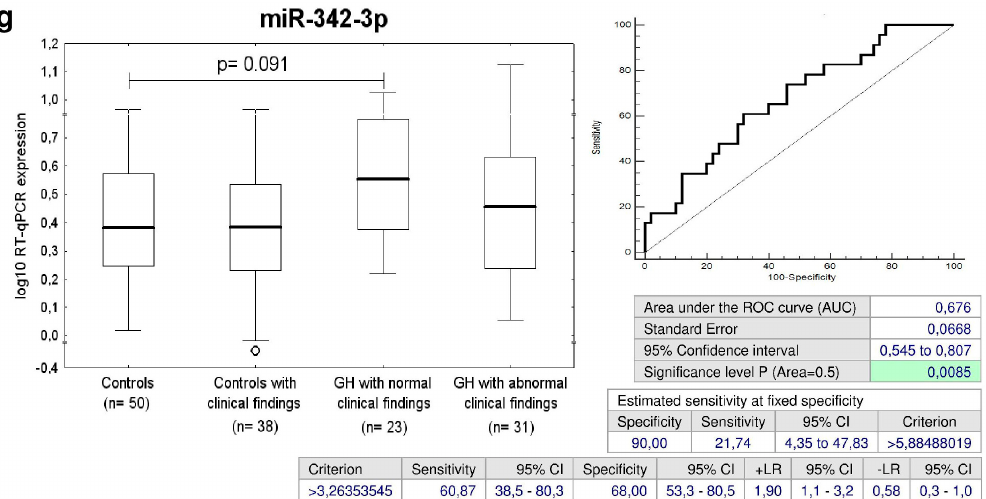
Figure 3. Postnatal microRNA expression profile in children with normal postnatal clinical findings descending from GH pregnancies. ( a – g ) Up-regulation of miR-21-5p, miR-23a-3p, miR-26a-5p, miR-103a-3p, miR-125b-5p, miR-195-5p and miR-342-3p was observed in children with normal postnatal clinical findings descending from GH pregnancies.